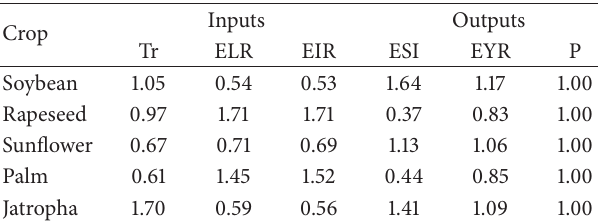
Table 9: The processed data of the inputs and outputs of DEA assessment system.